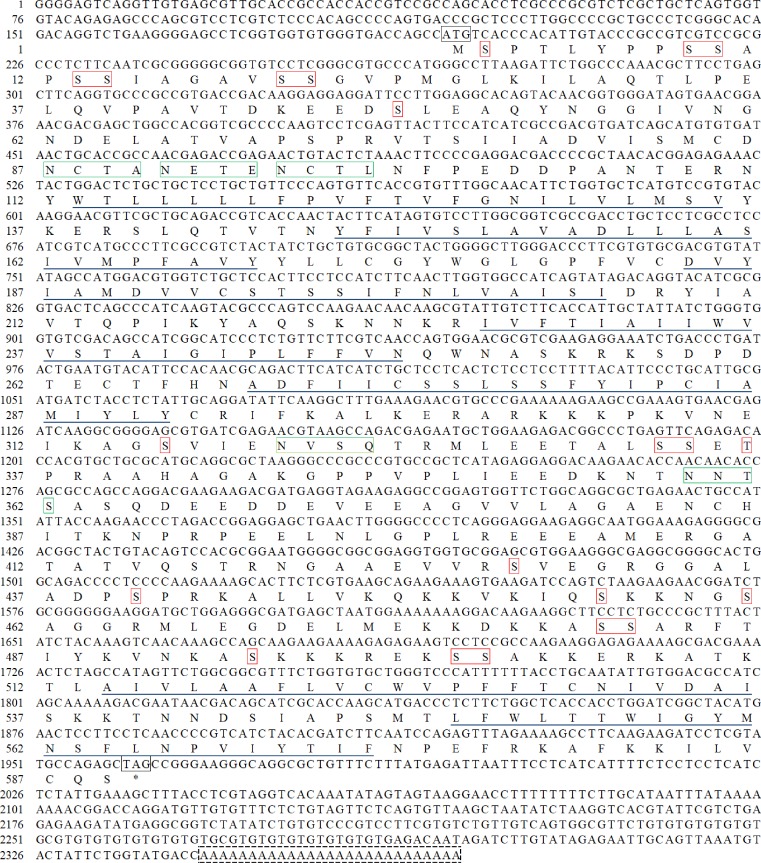
Nucleotide and deduced amino acid sequences of the DA2 gene.The nucleotide sequence is enumerated from the 192bp end and the single-letter amino acid code is shown above each corresponding codon. The start codon (ATG) and the stop codon (TAG) are indicated in the black boxes. The putative phosphorylation sites are indicated in the red boxes. The putative N-glycosylation sites are indicated in the green boxes. The seven transmembrane regions are underlined. Dashed boxes indicate the poly (A) tail.